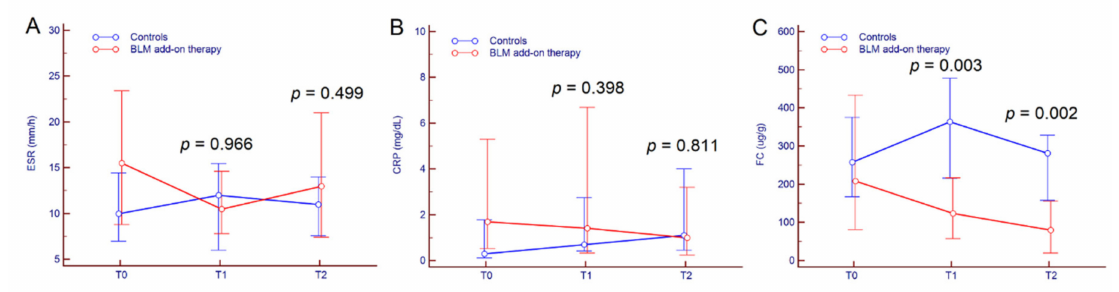
Figure 3. Kinetics of ESR ( A ), CRP ( B ), and FC ( C ) from T0 to T2 in UC patients treated with BLM add-on therapy and in the control group. Comparison between groups at di ff erent time-points was performed by a Mann–Whitney test. Abbreviations: microencapsulated sodium butyrate (BLM), fecal calprotectin (FC), C reactive protein (CRP), and erythrocyte sedimentation rate